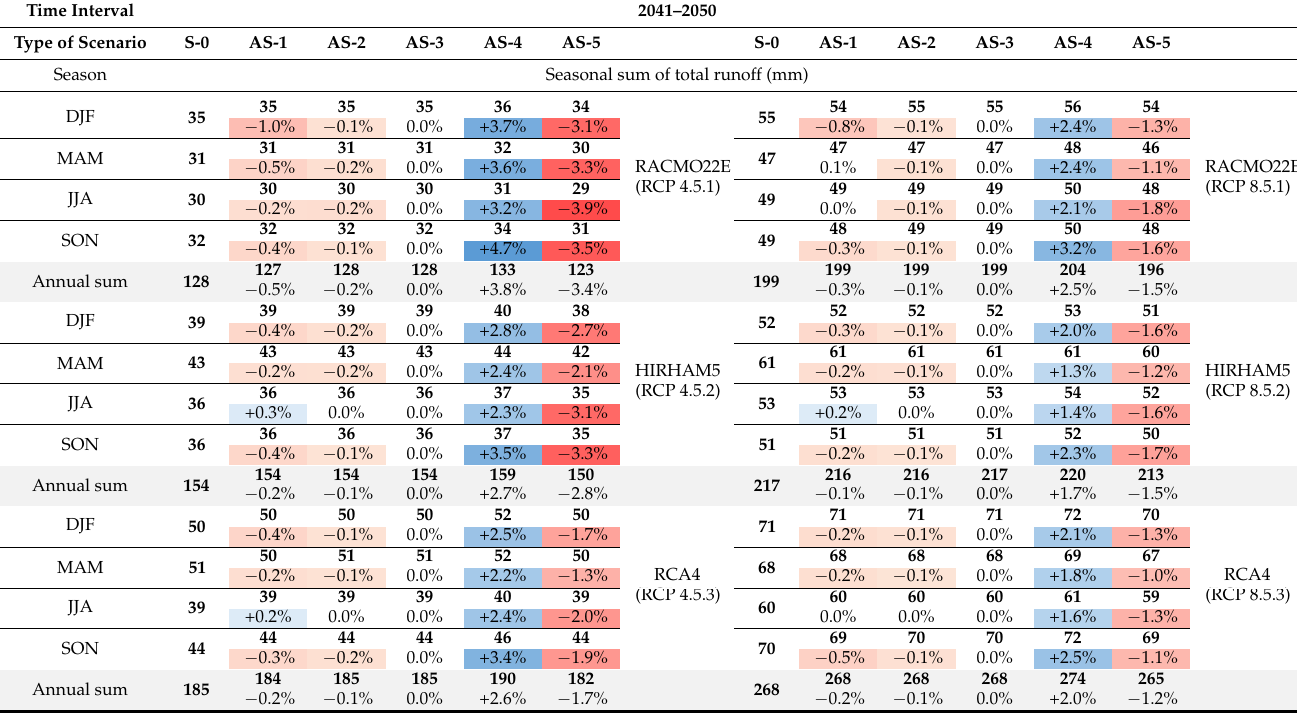
Table 7. Comparison of seasonal total runoff between scenario 0 (S-0) and adaptation scenarios 1–5 (AS-1, AS-2, AS-3, AS-4, AS-5) for 2041–2050 in the Bystra catchment for climate projections RCP 4.5.1, shaded numbers indicate percentage changes (red indicates % decrease in content, and blue indicates % increase in content). Dark red and dark blue shading indicates large changes, while light red and light blue shading indicates small changes (own study).